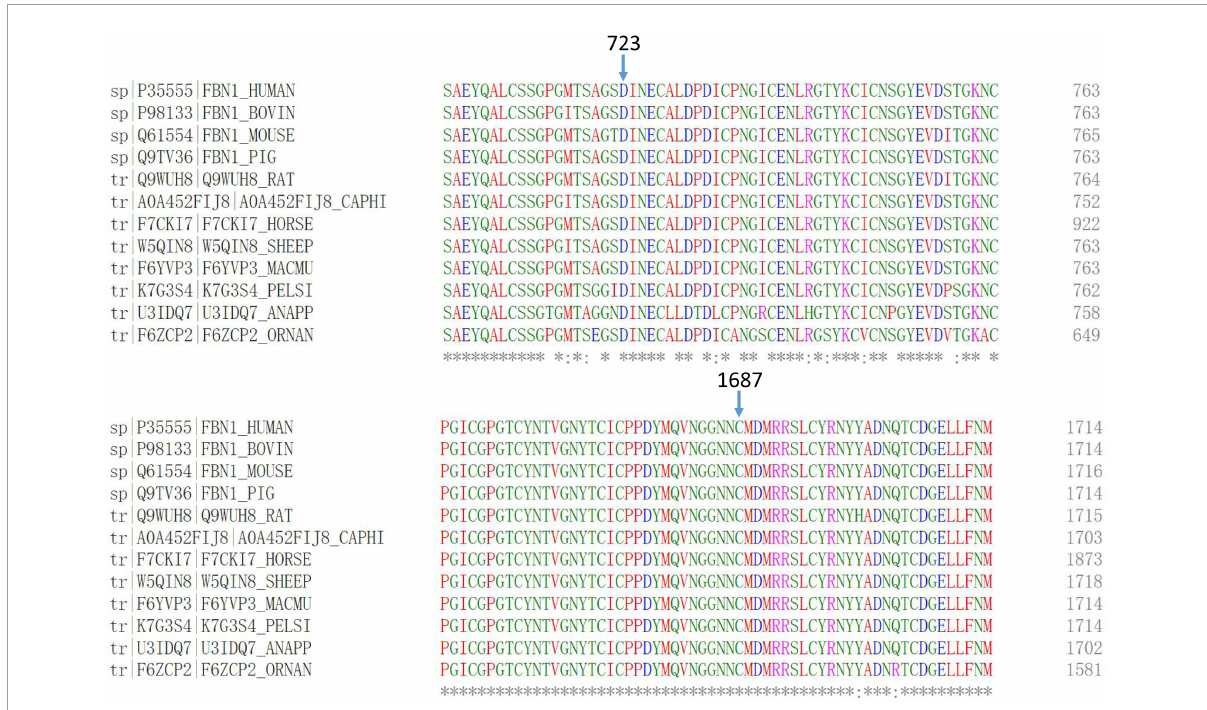
FIGURE3 Multiple-sequence alignments of FBN1 showed that codons 723 and 1,687 were highly conserved among several species.